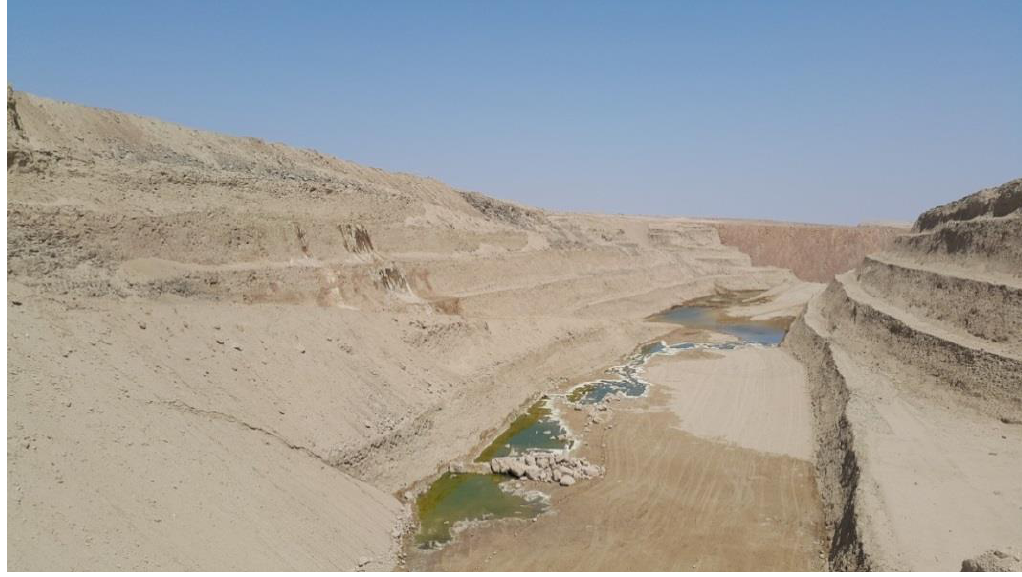
Figure 5. Seepage outlet at Langerheinrich Uranium Mine.